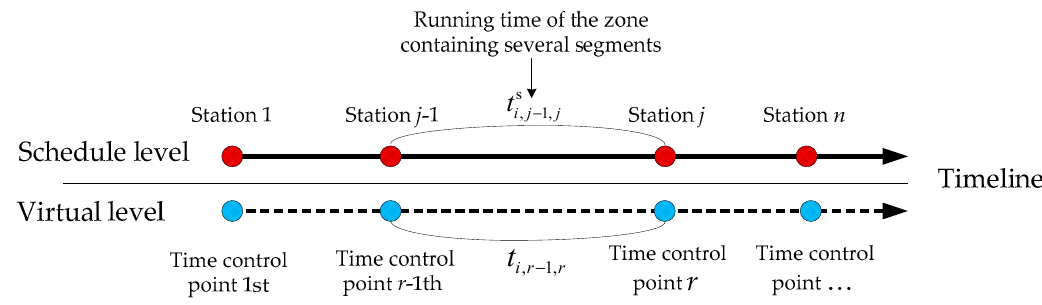
Figure 8. Illustration of time control point strategy.